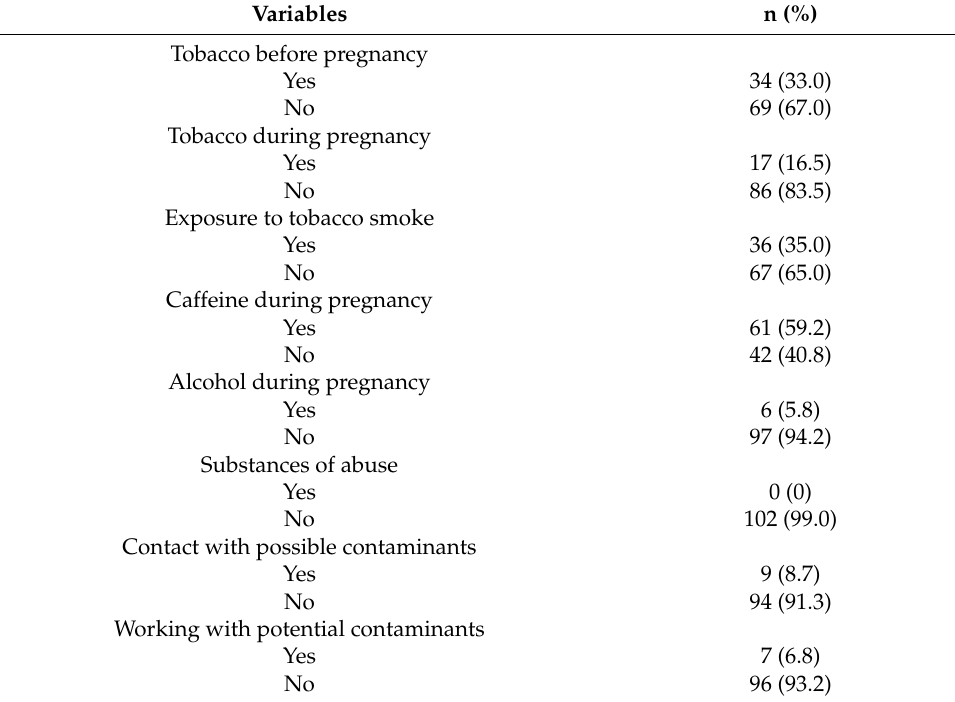
Table 2. Frequency of possible exposure to environmental pollutants in pregnant